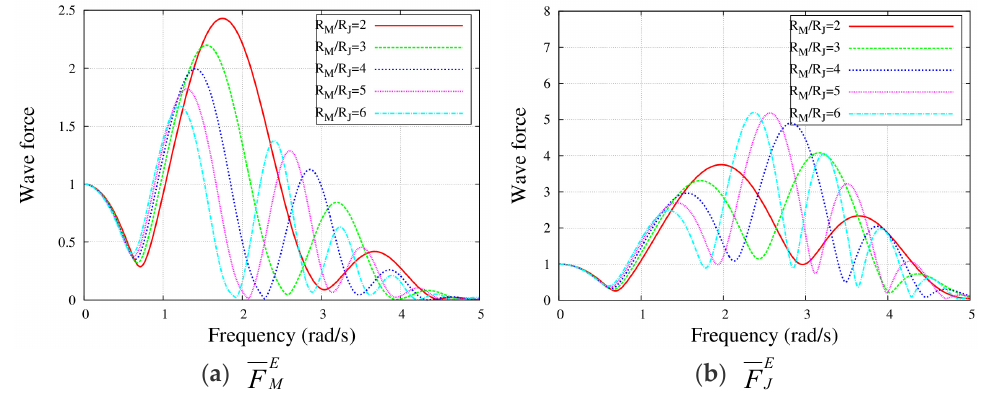
Figure 5. Variation of wave force with frequency on the moon pool platform and sea javelin for different radius ratios.